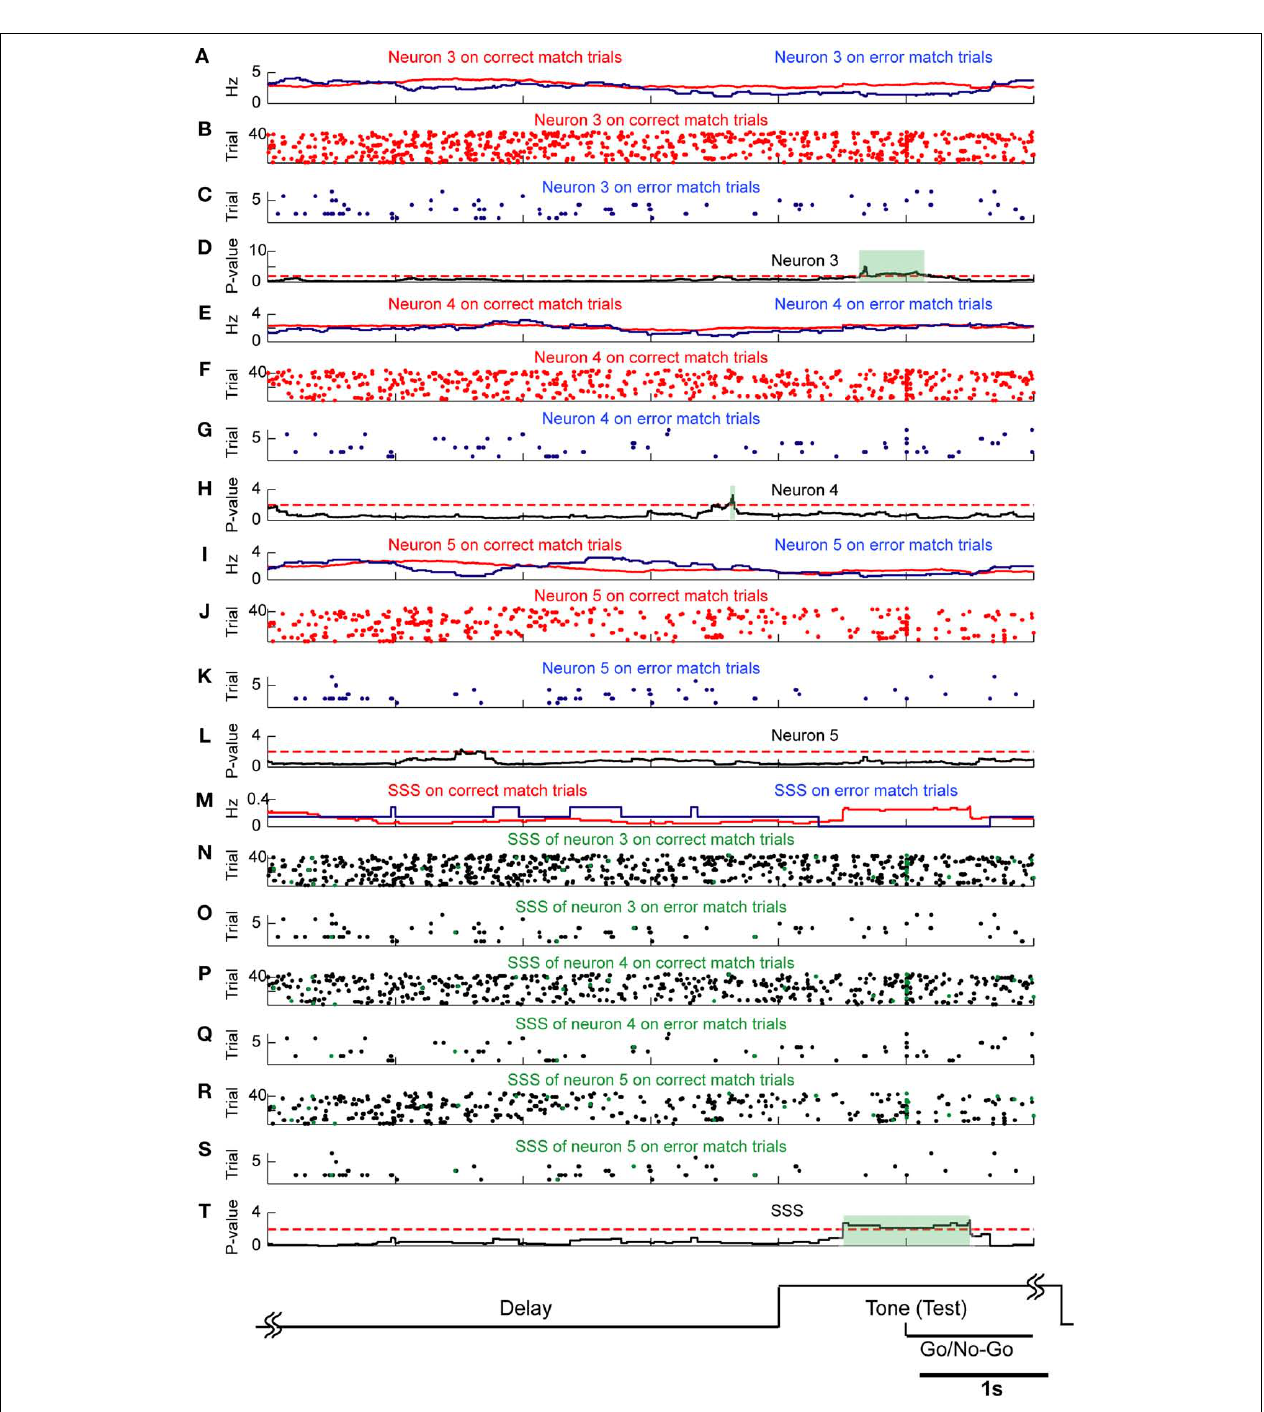
FIGURE 13 | SSSs among a triplet of neurons related to comparison of the stimuli are associated with fi ring rate modulations. The comparison of SSSs and rate modulations between correct match (red) and error match (blue) trials was selected in this example. Results of U -tests of 4 s of delay and 2 s of tone presentation are shown. (A) Firing rates of neuron 3 in correct match (red) and error match (blue) trials. (B,C) Raster plots of spikes of neuron 3 in correct match (red) and error match (blue) trials. (D) P -values of neuron 3 for a difference between rates in correct match trials and in error match trials. (E) Firing rates of